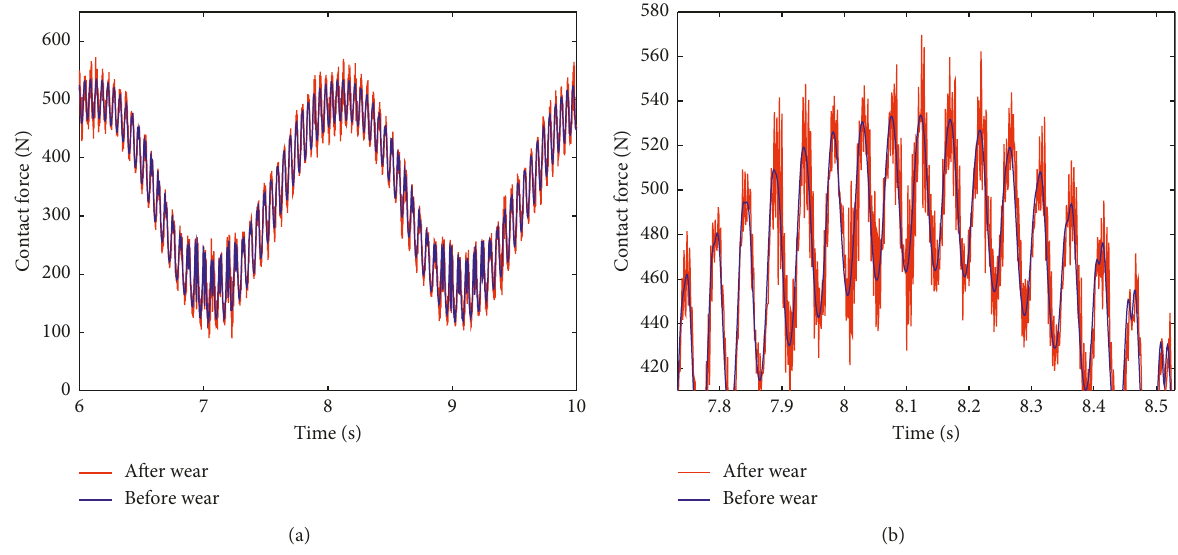
Figure 13: Comparison of contact force curve before and after wear: (a) contact force curve and (b) enlarged view of the contact force